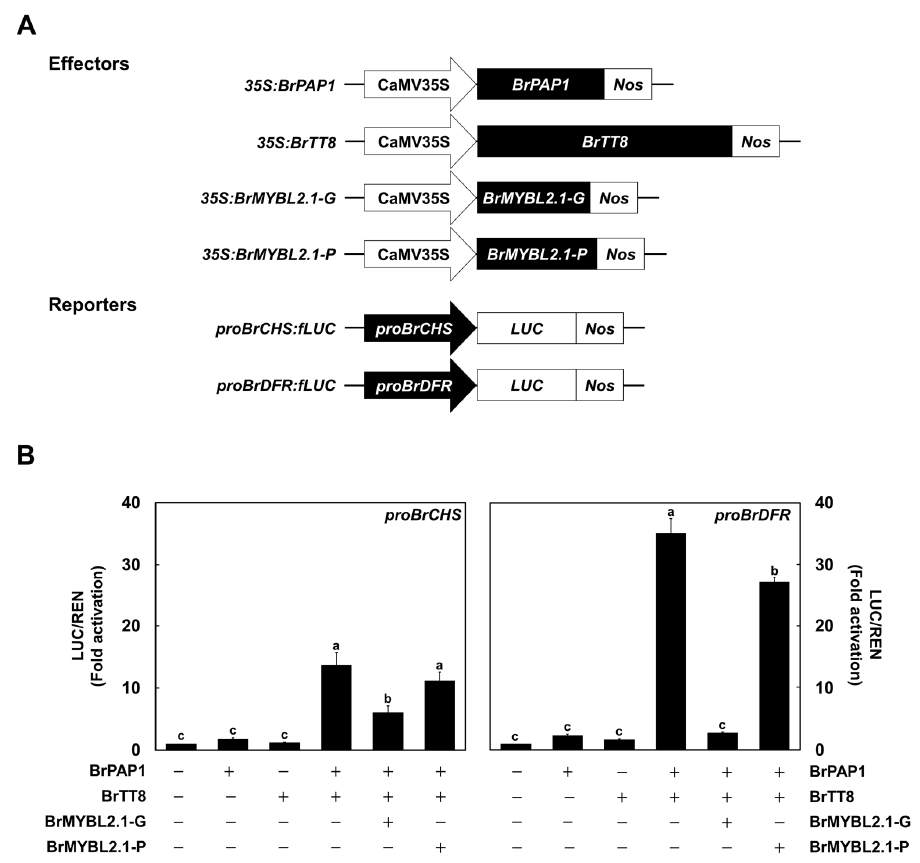
Figure 8. Characterization of the regulatory roles of BrMYBL2.1 ‐ G and BrMYBL2.1 ‐ P for BrCHS and BrDFR promoter activation. ( A ) Schematic diagrams of the effector and reporter constructs used in this assay. The effector constructs consist of the coding sequences of BrPAP1 , BrTT8 , BrMYBL2.1 ‐ G , and BrMYBL2.1 ‐ P driven by the 35S promoter. The reporter constructs contain the firefly luciferase reporter gene ( LUC ) under the control of the BrCHS and BrDFR promoters. ( B ) Promoter transactivation assays in Arabidopsis protoplasts transiently transfected with the constructs BrPAP1 , BrTT8 , BrMYBL2.1 ‐ G , and BrMYBL2.1 ‐ P in the indicated combinations. Results are the means ± SD from three independent biological replicates. Different letters indicate significantly different values ( p < 0.01), as determined by one ‐ way ANOVA followed by Duncan’s multiple range tests.